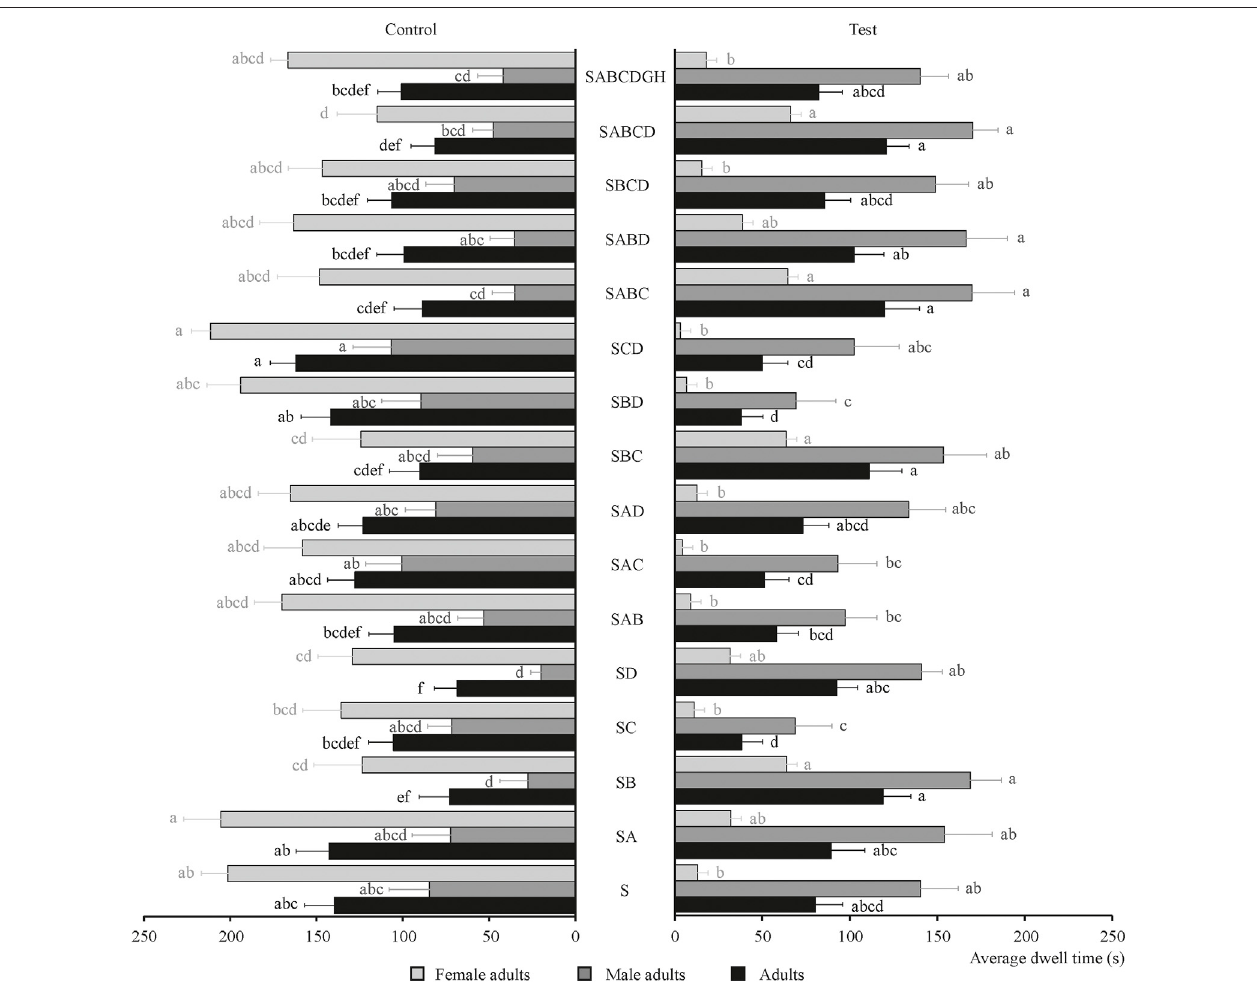
FIGURE 3 | An average dwell time of male adults, female adults, and adults of tobacco beetle in the combination of chemical substances and sexual attractants. Different lowercase letters in the fi gure represent the average dwell time of male adults, female adults, and adults of tobacco beetles with a signi fi cant difference at p < 0.05 in different combinations. Error bars shown in the fi gure represent mean ±